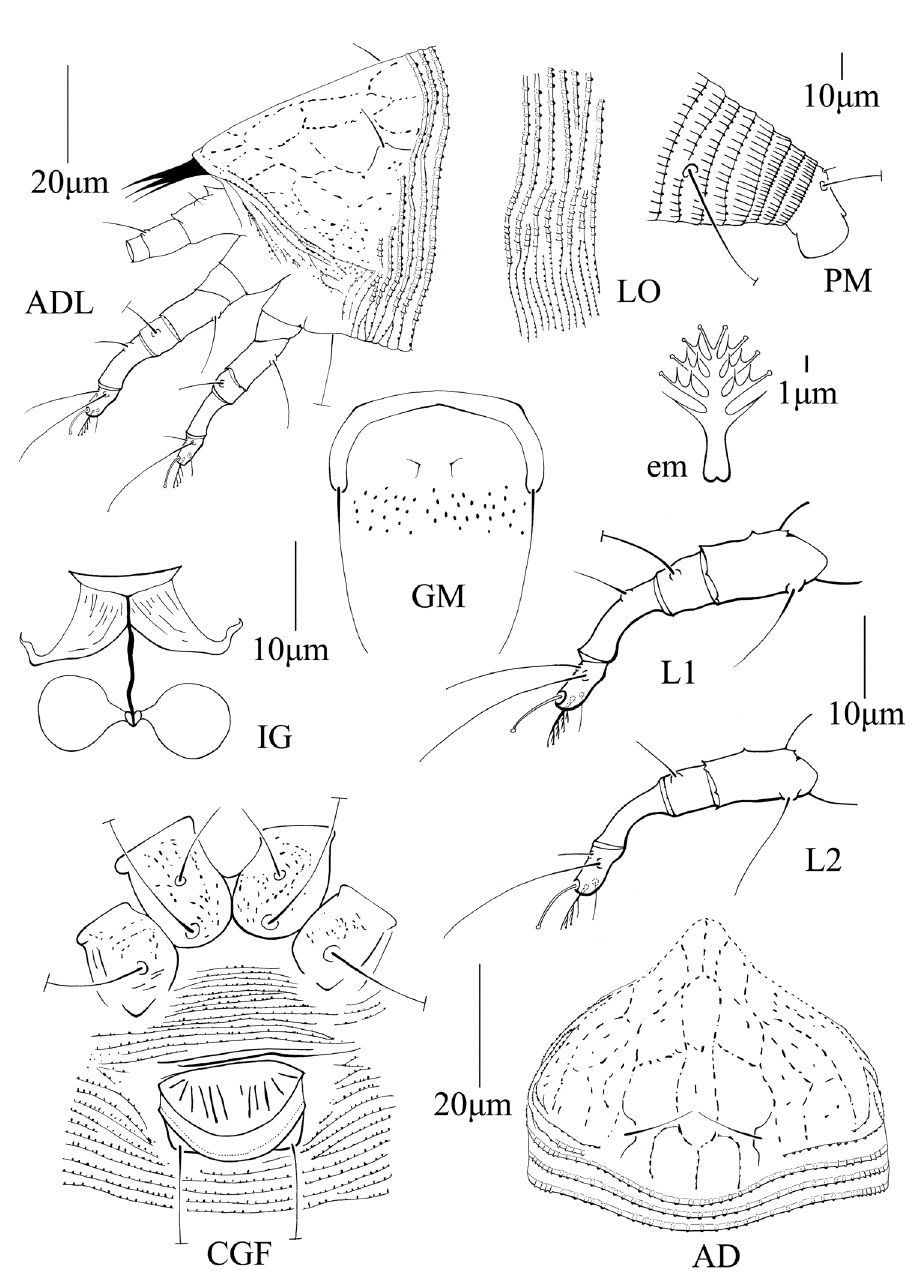
Figure 4. Schematic drawings of Phyllocoptes terniflores sp. n.: ADL lateral view of anterior body region (slightly rotated dorsad) LO lateral view annuli PM lateral view of posterior opisthosoma em empodium GM male genital region IG female internal genitalia L1 leg I L2 leg II CGF female coxigenital region AD prodorsal